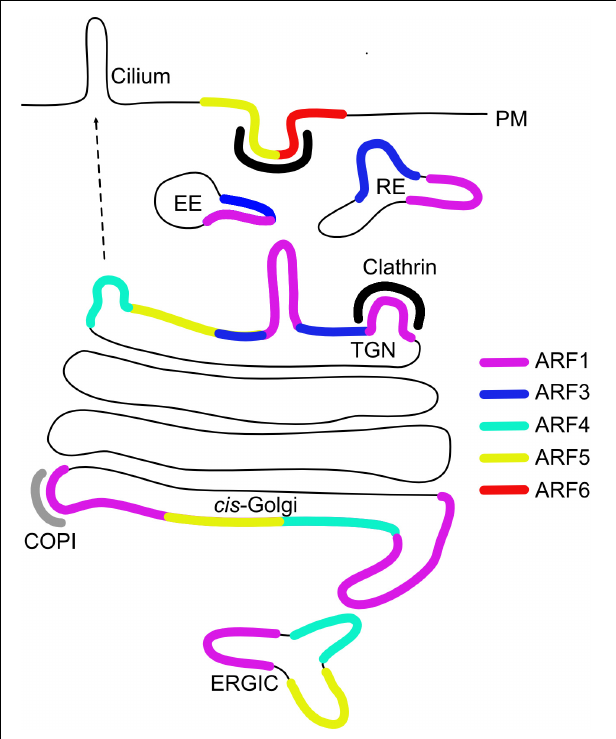
FIGURE 1 | Intracellular localization of ARF GTPases. Early endosome (EE), recycling endosome (RE), trans -Golgi network (TGN), ER-Golgi intermediate compartment (ERGIC), and plasma membrane